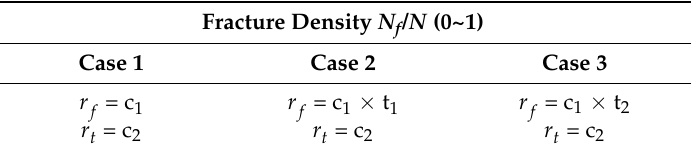
Table 1. Parameters used in the simulations.